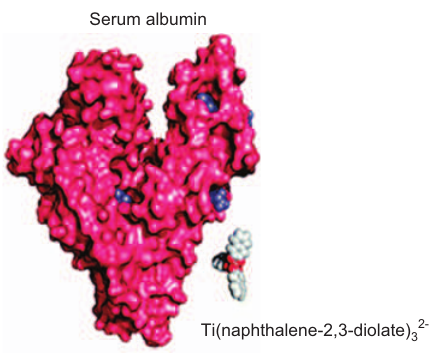
Figure 4 Ti(IV), 2.3-dihydroxynaphthalene and bovine